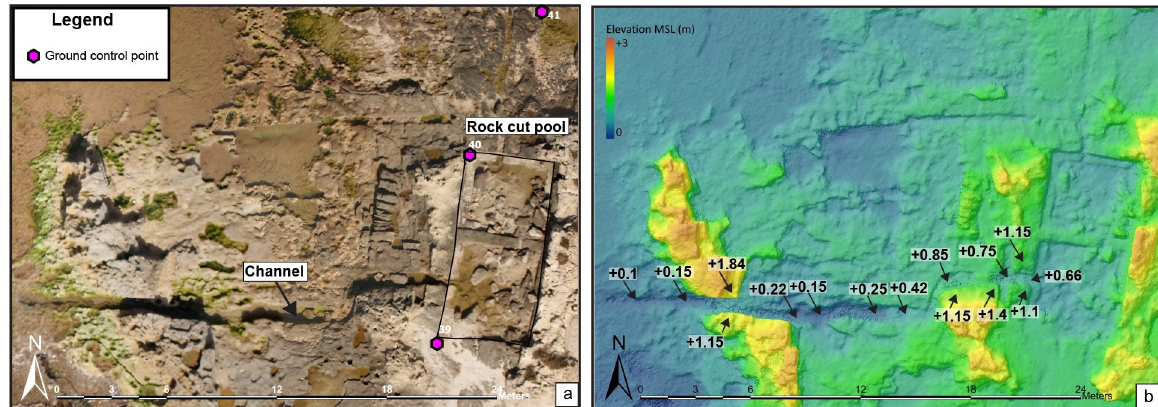
Fig 3. Elevation model of the Roman rock cut pool from Dor. (a) aerial photograph of the rock cut pool with ground control points used for georectification (b) a digital elevation model of the pool. The color indicates elevation variation while the black arrow shows elevation changes (relevant to MSL) in and adjacent to the Roman rock cut pool’s